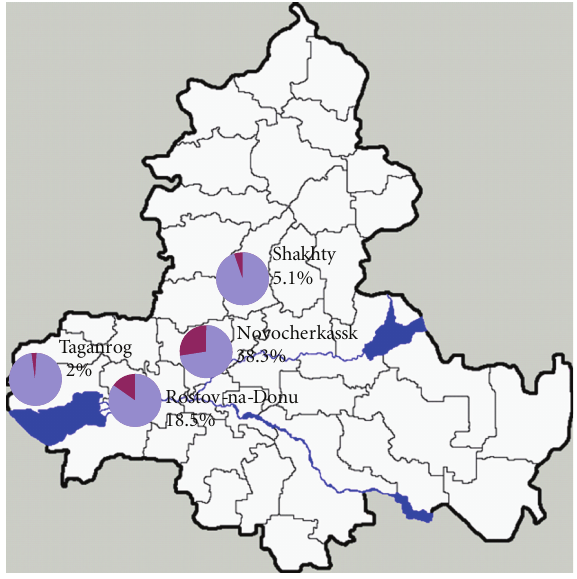
Figure 1: Rostov Region map. Occurrence of canine dirofilariosis at di ff erent points of the